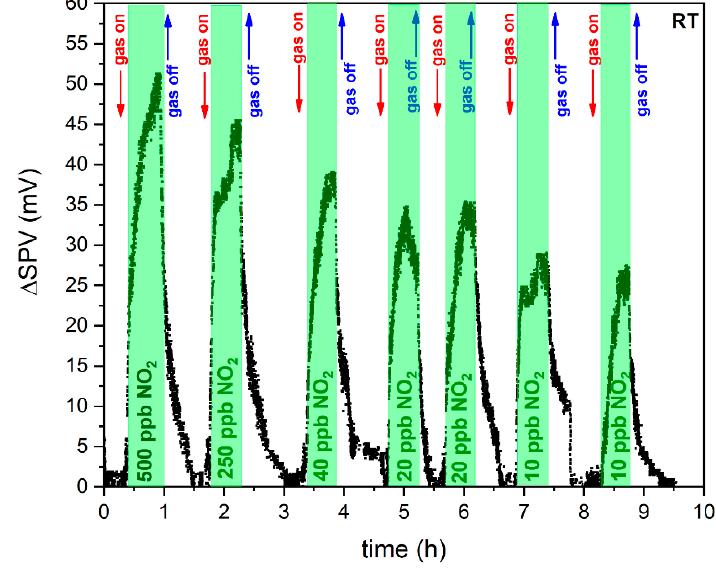
Figure 1. The variation of amplitude of surface photovoltage (SPV) signal for rheotaxial growth and vacuum oxidation (RGVO) SnO x nanolayers after exposure to sequential relative concentration of 500, 250, 40, 20 and 10 ppb NO 2 in synthetic air; areas depicted in green indicate the time interval when the step change of NO 2 concentration appeared; the measurements were performed at room temperature